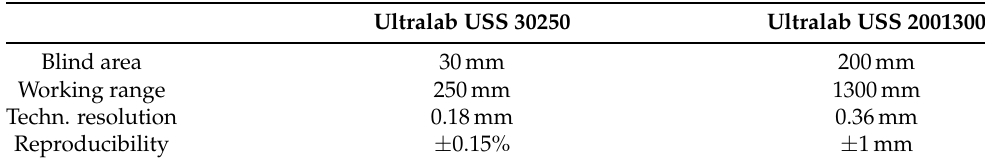
Table A1. Technical details of the applied ultrasonic (us)